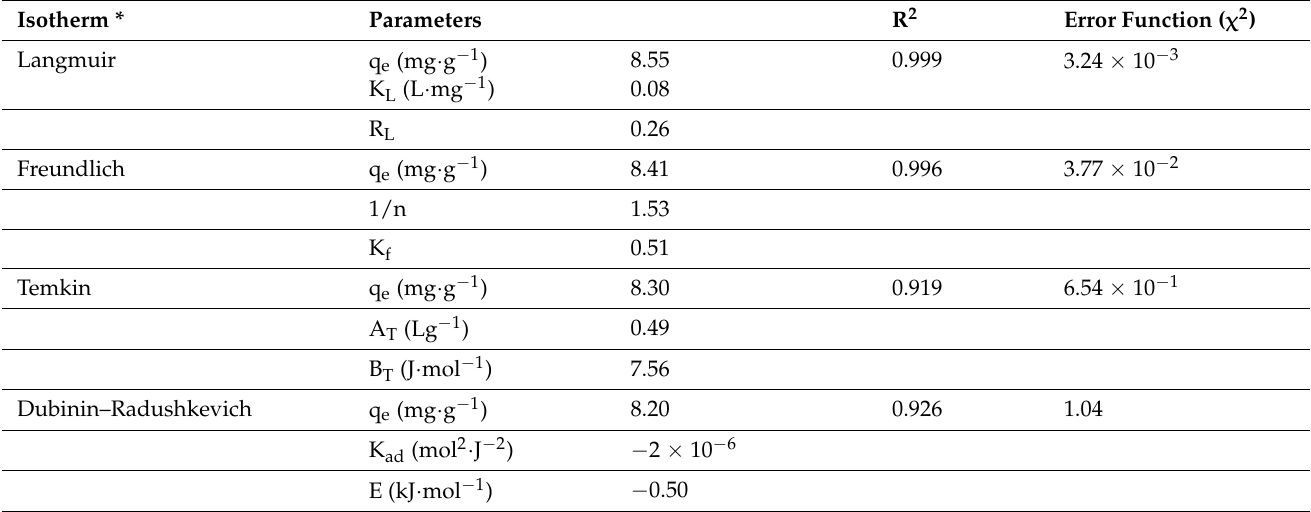
Table 3. Parameters of various adsorption isotherms calculated using linear equations for adsorption of CTM onto citric-acid-modified Moringa peregrina leaf adsorbent at room